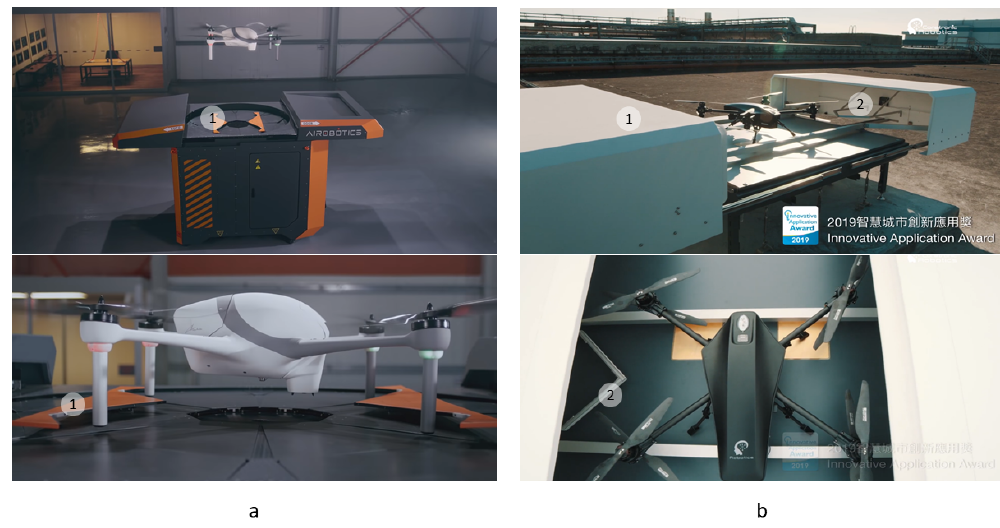
Figure 15. Examples of commercially available platforms for UAVs with V- and W-shaped pushers. ( a ), Airobotics [55] station with parallel W-shaped pushers (1); ( b ), Coretronic Intelligent Robotics (CIRC) [56] station with V-shaped pushers (2) integrated with doors